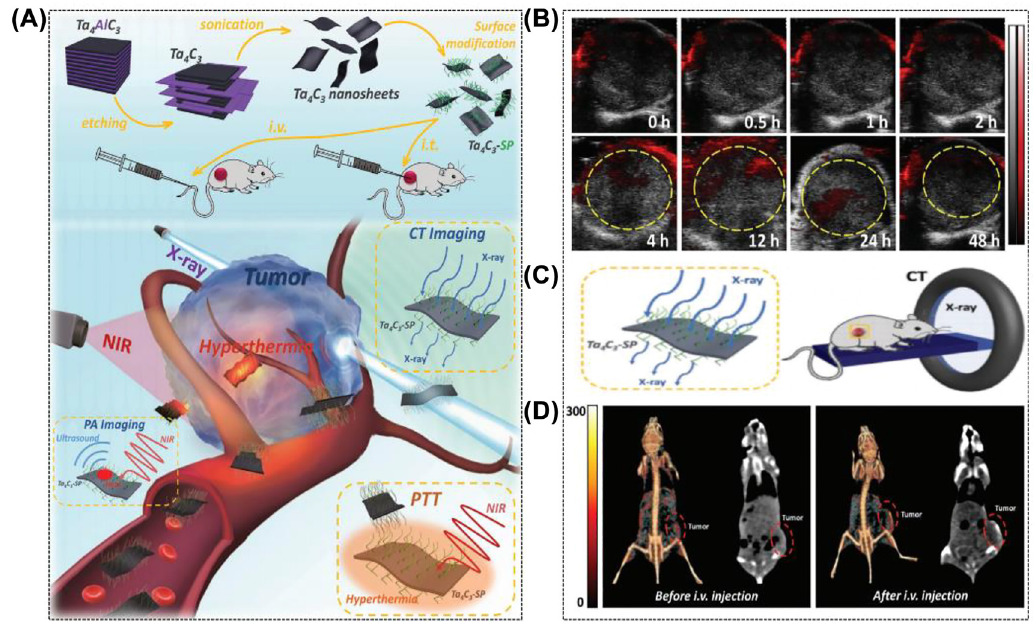
C nanosheet synthesis and in vivo PA/CT dual-mode 4 3